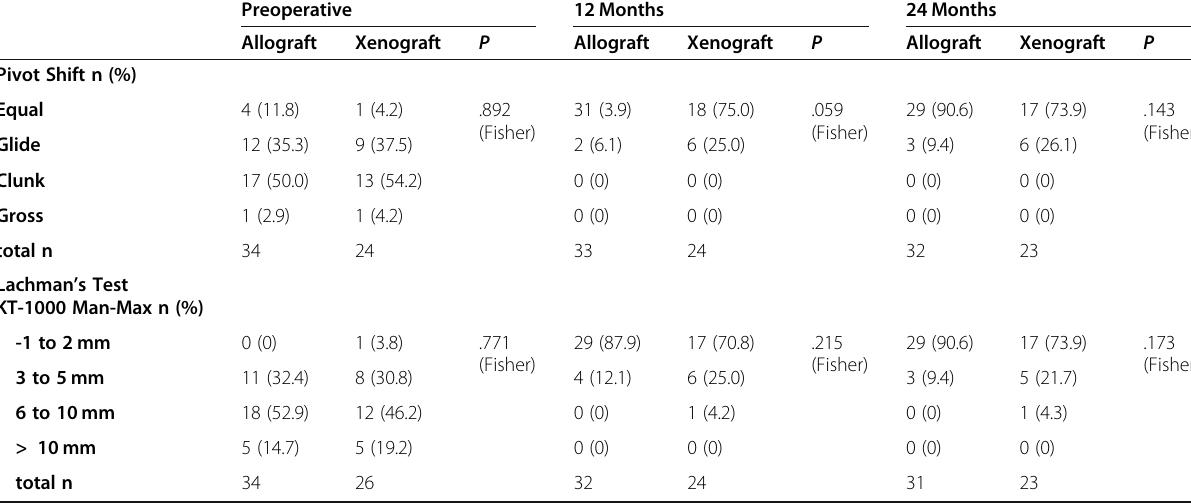
Table 4 Objective Knee Laxity Evaluation - Missing/Contaminated Graft Subjects Excluded